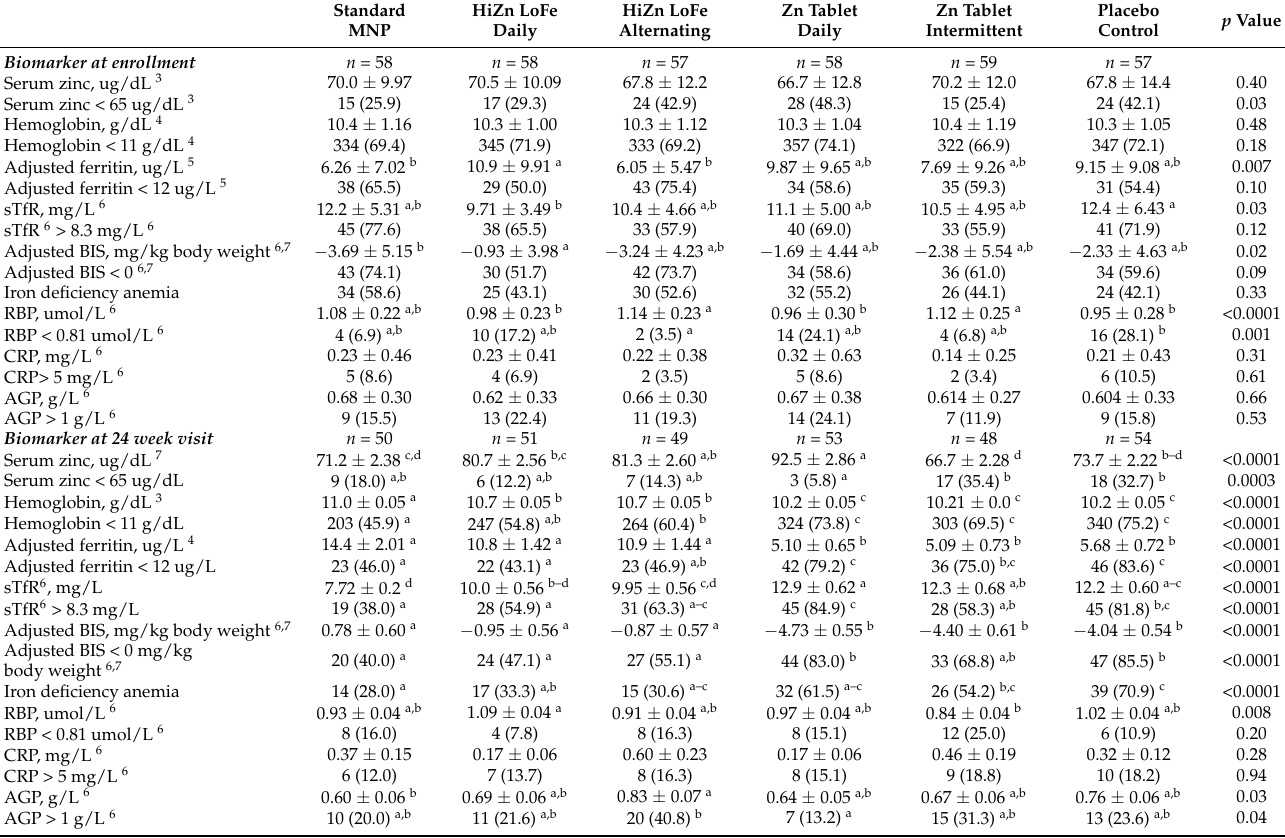
Table 2. Biomarkers of micronutrient status and inflammation at enrollment and at the 24 week visit, by group assignment 1,2 . HiZn LoFe